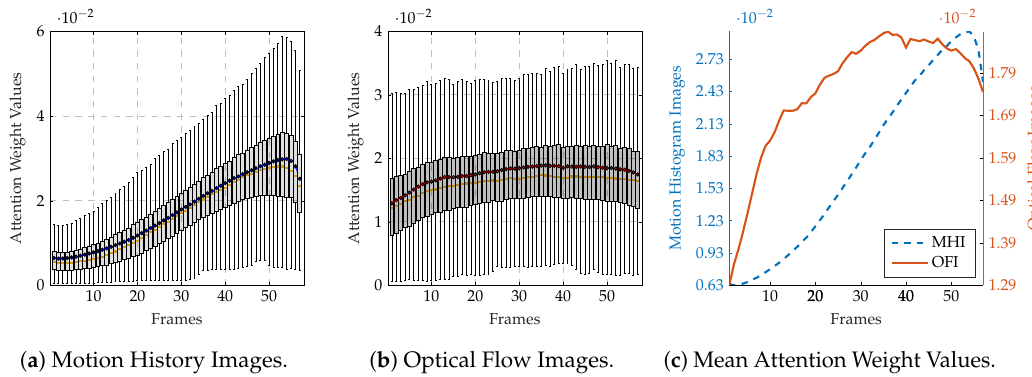
Figure 7. BioVid Heat Pain Database (Part A): Attention network weight values for the classification task T 0 vs . T 4 . Within each boxplot in ( a , b ), the mean and the median weight values are depicted, respectively, with a dot and a horizontal line. In ( c ), the average weight values are normalised between the maximum average value and the minimum average value to allow a better visualisation of the values